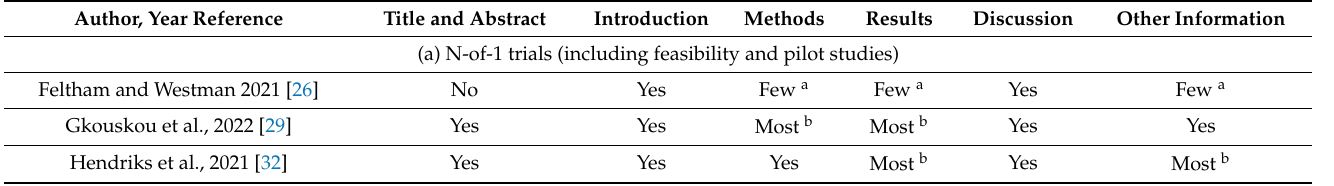
Table 2. Quality assessment of reporting of items in the CENT 2015 checklist [22] or STROBE checklist